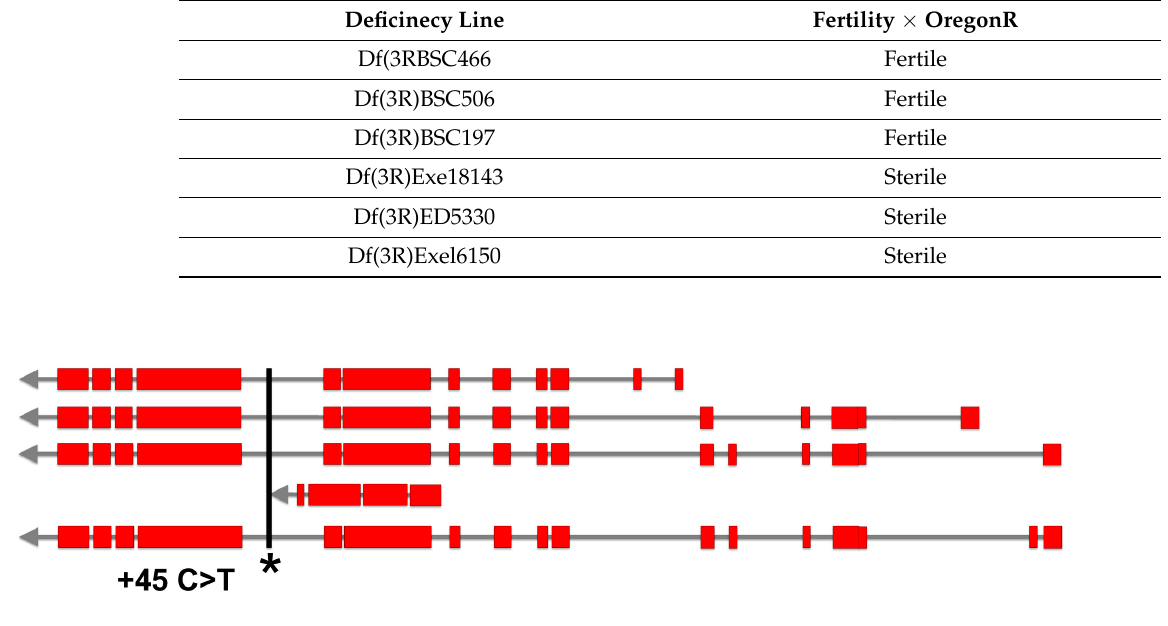
Table 1. Male fertility status of selected Drosophila deficiency lines.